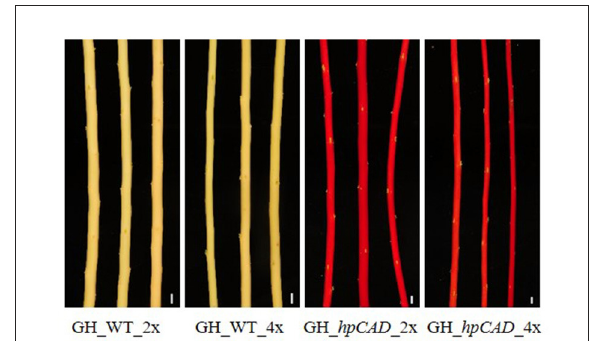
FIGURE3 Xylem coloration of greenhouse-grown di- and tetraploid debarked poplar stems. The red xylem phenotype characteristic for CAD1 -downregulation is maintained after whole genome duplication. Pictures are representative for the different independent lines. Scale bars =